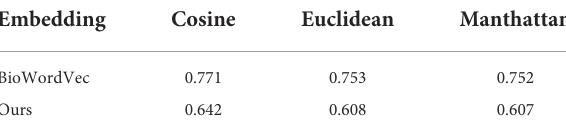
TABLE 2 Comparison between proposed embeddings (ours), the state-of-the-art in English (BioWordVec), and a similar model in Spanish (SHE) using the UMNSRS-Sim set.